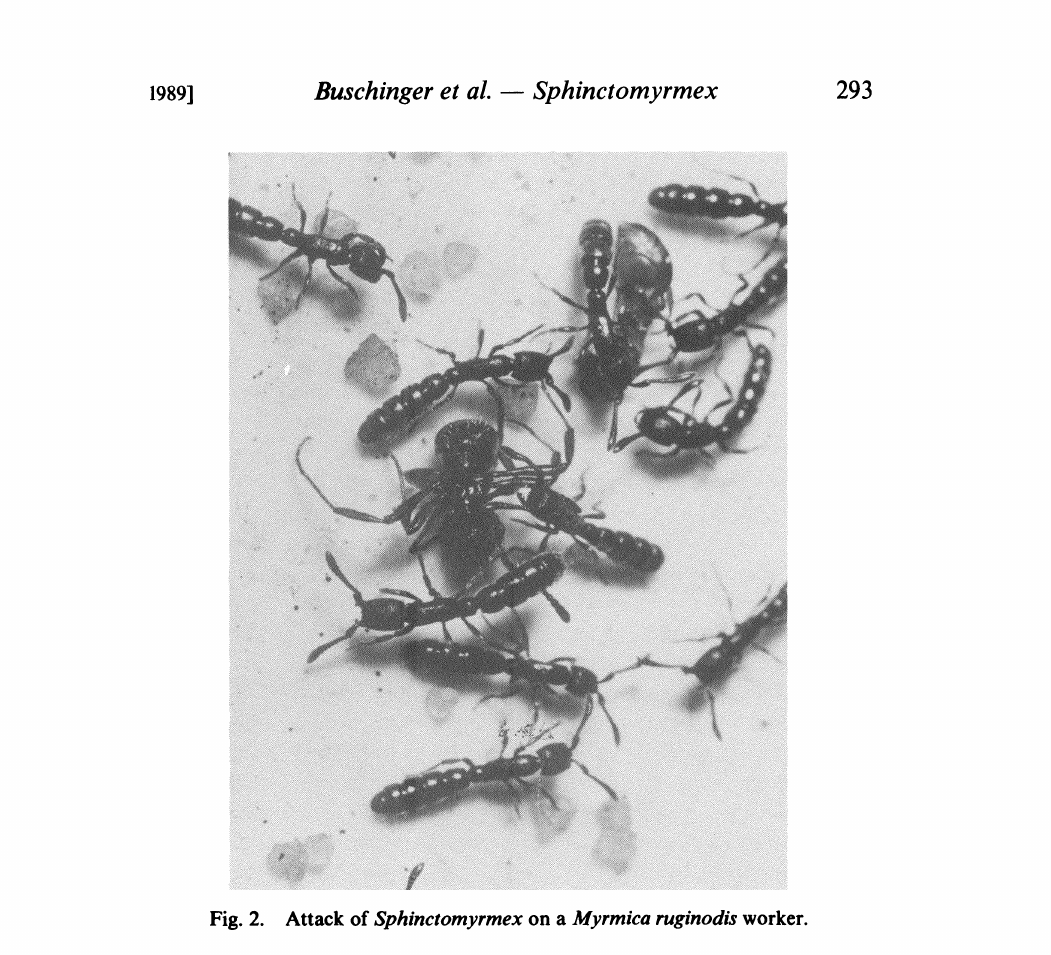
Fig. 2. Attack of Sphinctomyrmex on a Myrmica ruginodis